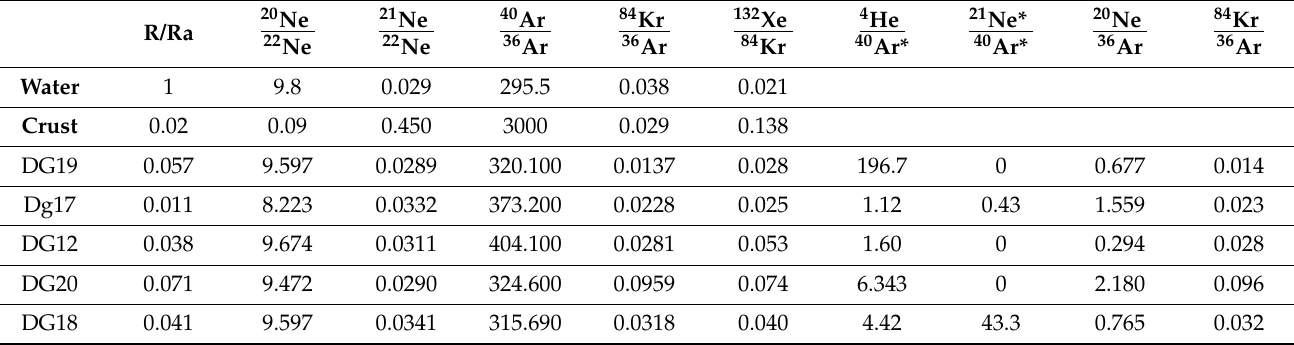
Table 5. Select sample noble gas ratios compared to water and crustal ratios.